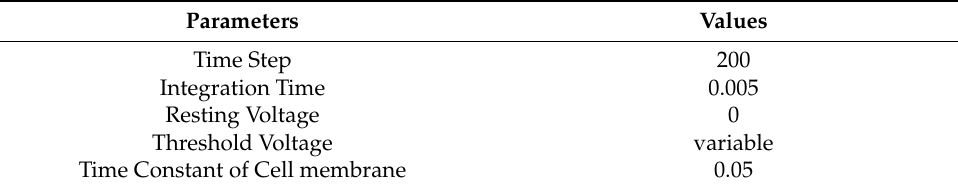
Table 3. Parameters of SNN Model Network.